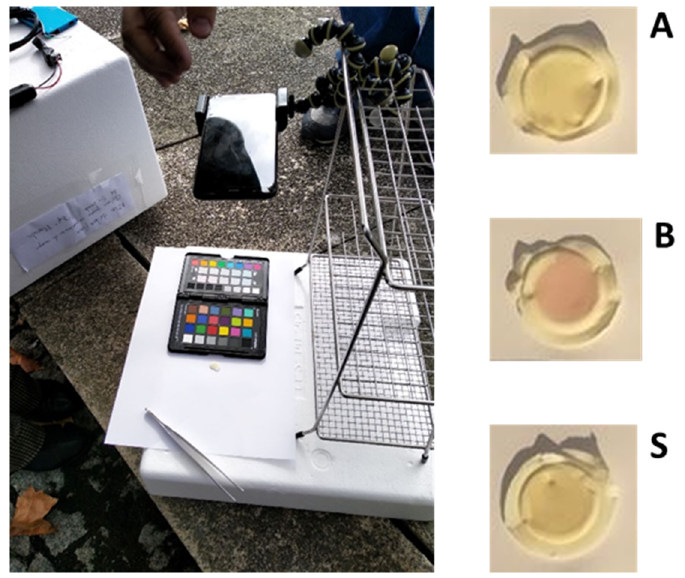
Figure 4. Set-up for in-field screening of SMZ and results from a test sample S (A—negative control, absence of SMZ; B—positive control, SMZ at 25 µg L − 1 ).